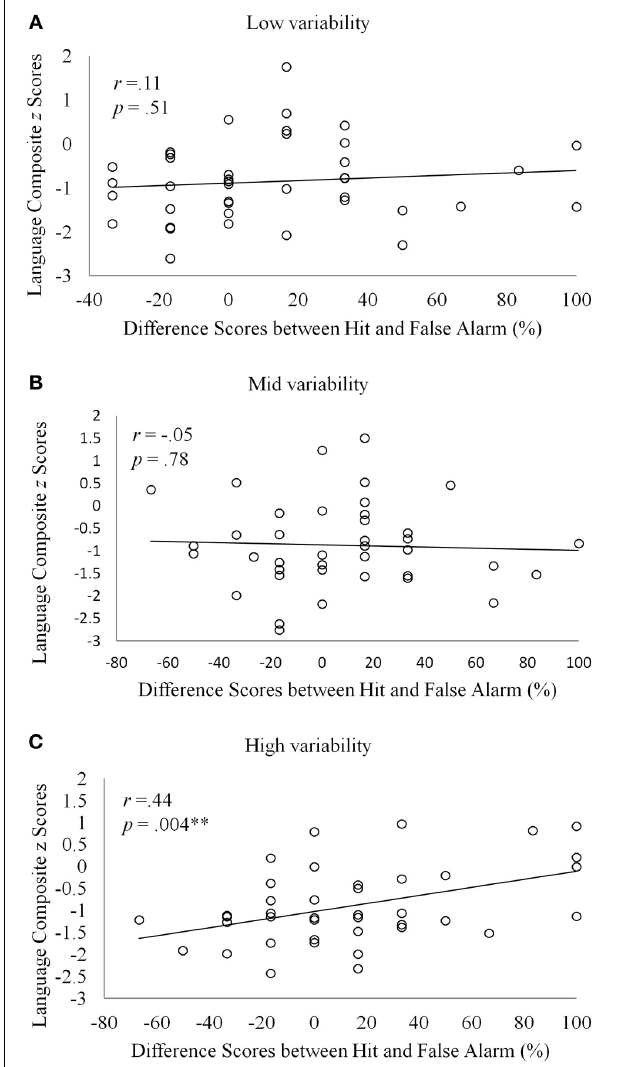
FIGURE 2 | Scatter plots of language composite z scores and the difference scores between hit and false alarm for the (A) low, (B) mid, and (C) high variability